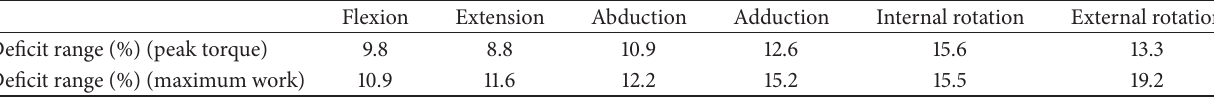
Table 3: The peak torque and maximum work deficit range for hip